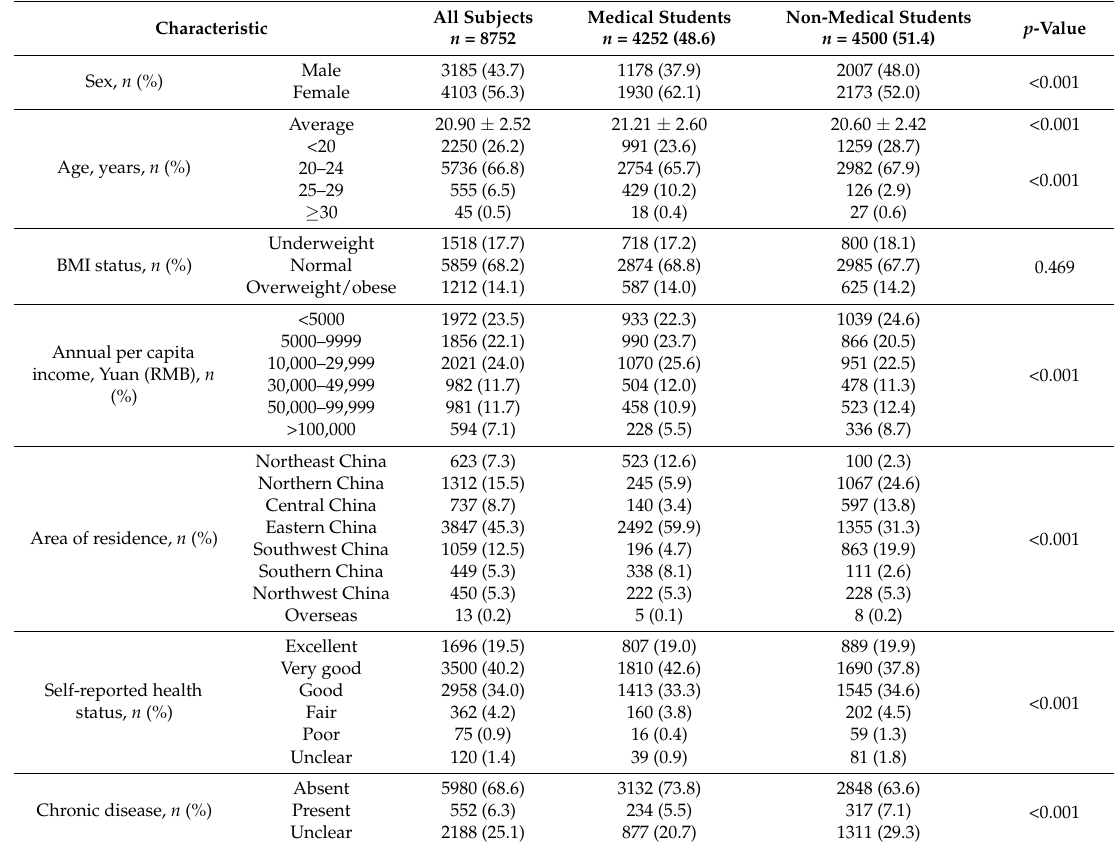
Table 1. Demographic characteristics of Chinese students in the